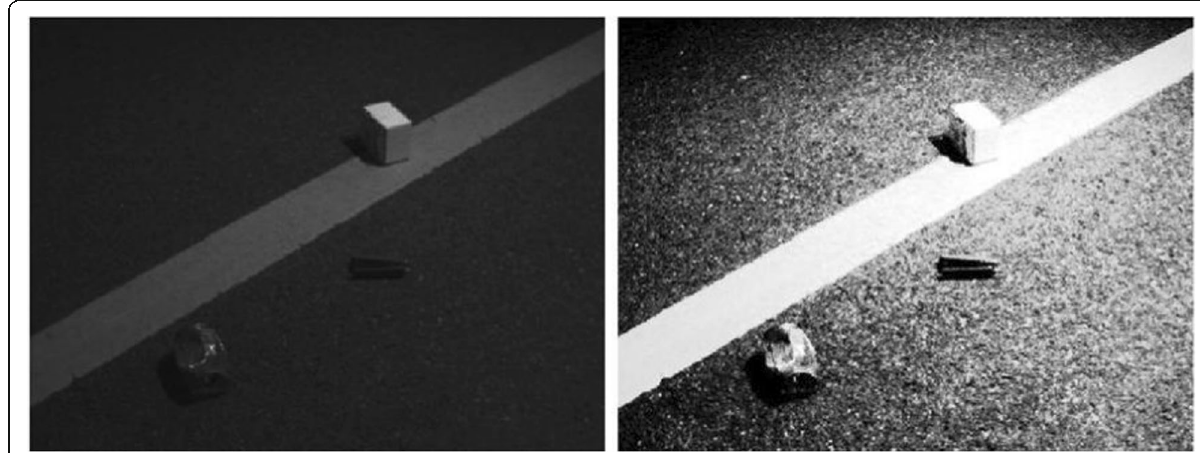
Fig. 5 Comparison of histogram equalization image enhancement effects. a Image before histogram equalization processing. b Image after histogram equalization